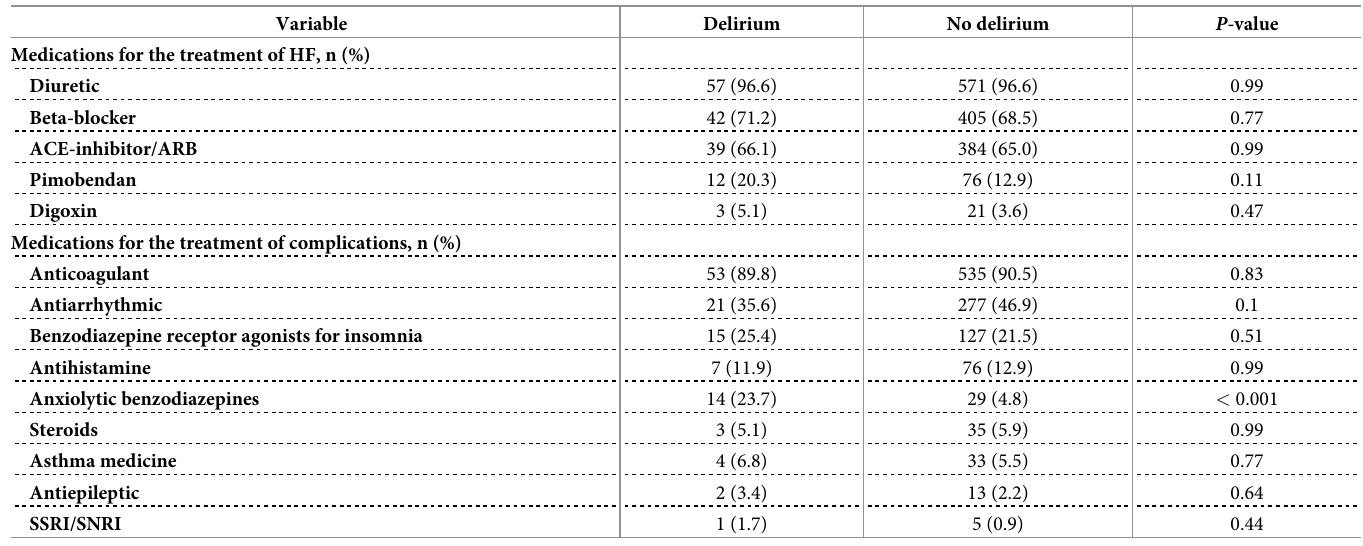
Table 2. Medications used for the treatment of HF and its complications.